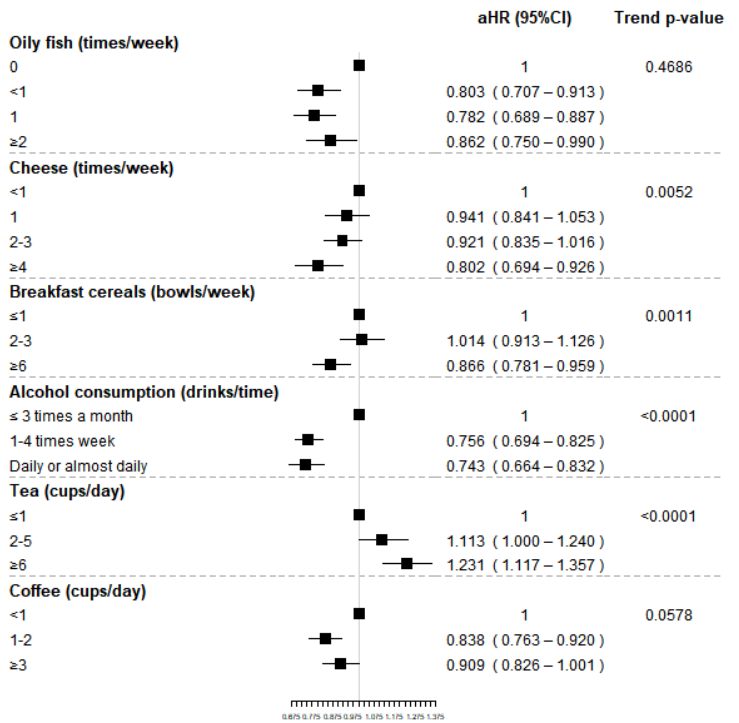
Figure 3. Adjusted hazard ratios (HR) and corresponding 95% confidence intervals (CI) for the association between selected food groups (shown in bold) and RA and p -value of the trend test.